Question: Identify the chart type used in this figure.
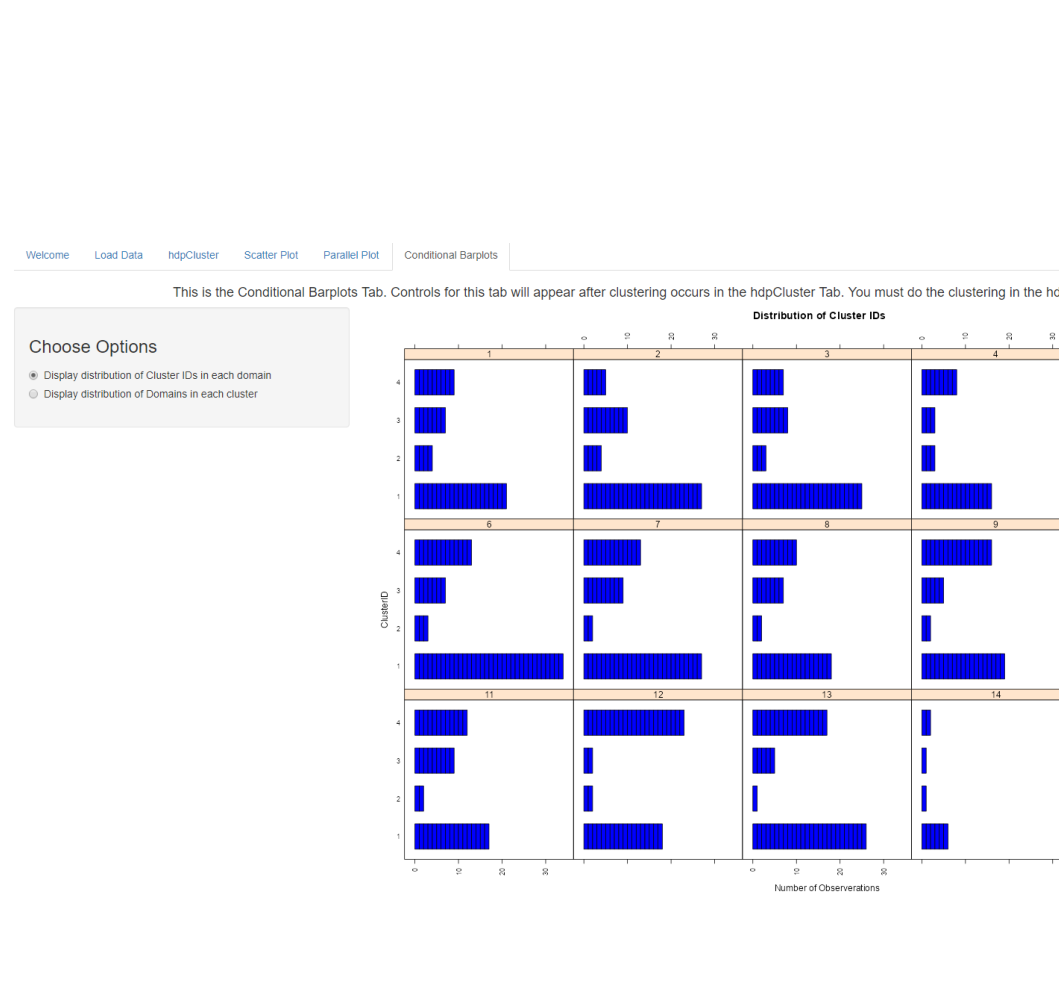
Answer: bar